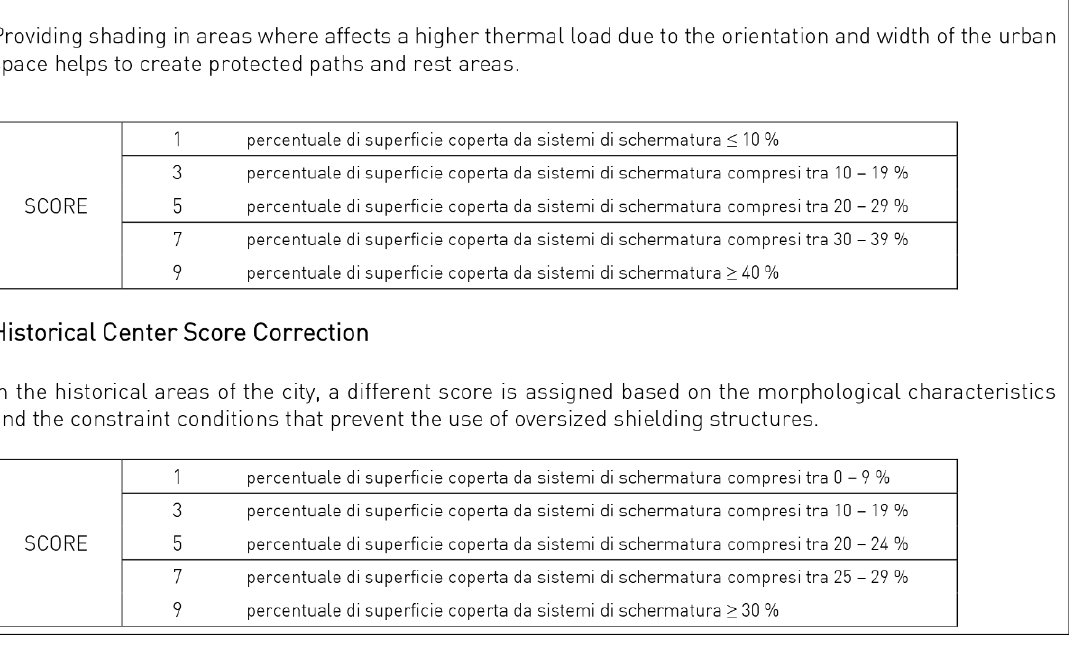
Figure A15. Descriptive sheet of the indicator of “Shading systems”.